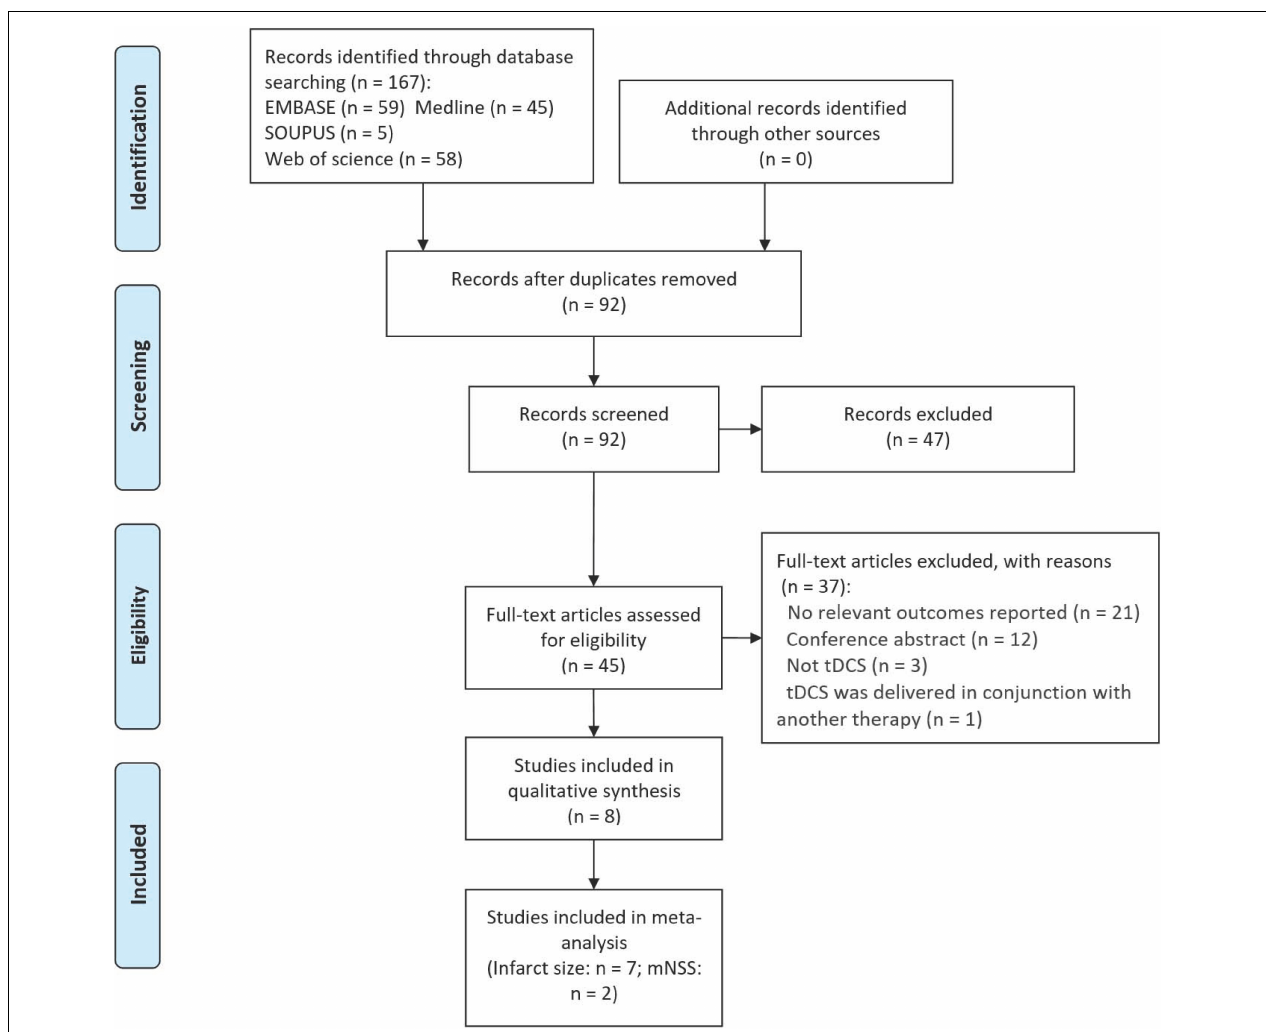
FIGURE 1 | PRISMA flow diagram for search strategy and study